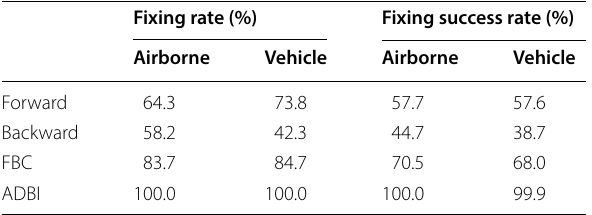
Table 1 The ambiguity fixing rate and ambiguity fixing success rate in different data processing strategy for airborne data and vehicular data